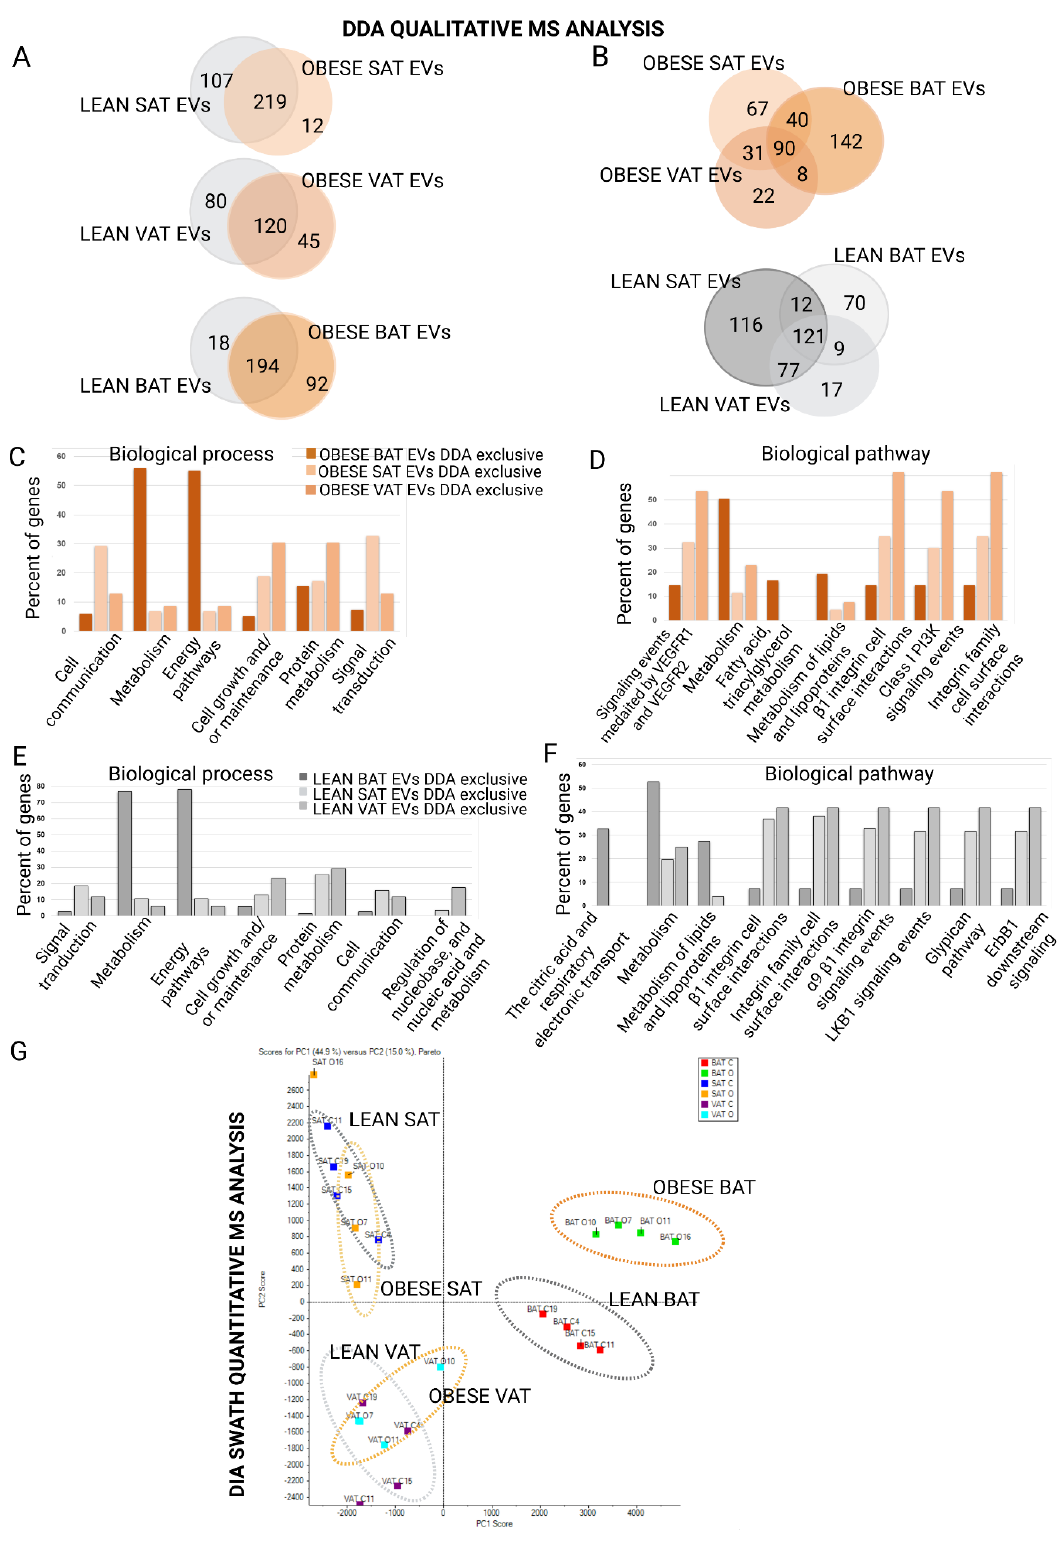
Figure 3. Qualitative (DDA) and quantitative (DIA-SWATH) analysis of the proteome of vesicles released from white (visceral, subcutaneous) and brown AT from lean (control) and obese animals: ( A , B ) Descriptive and comparative Venn diagram showing the total number of proteins identified with an FDR < 1% (99% protein confidence) in vesicles isolated from visceral (VAT), subcutaneous (SAT), and brown (BAT) adipose tissue from 4 control and 4 independent obese animals.